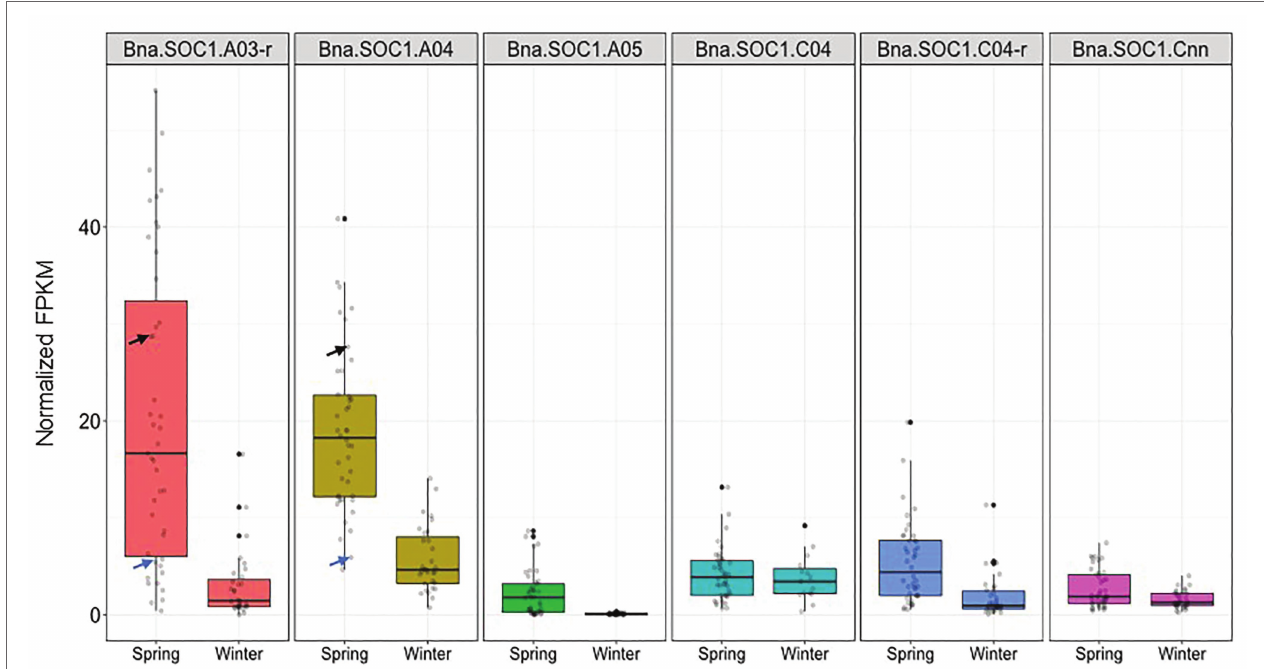
FIGURE 5 | Expression levels of Bna.SOC1 genes in spring and winter rapeseed accessions. Boxplot of normalized fragments per kilobase per million mapped reads (FPKM) values of the six Bna.SOC1 paralogs in leaf transcriptome of 31 winter and 41 spring rapeseed accessions. Black arrow corresponds to the normalized FPKM values of Adamo, while blue arrows correspond to the normalized FPKM values of